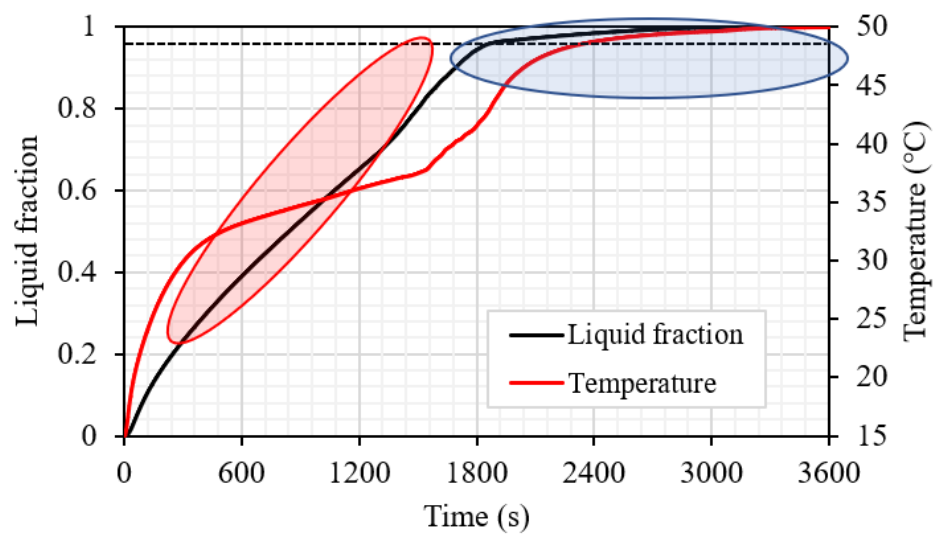
Figure 10. Liquid fraction and mean temperature profiles for the best case (case 3), which is dependent on the next steps of this study.